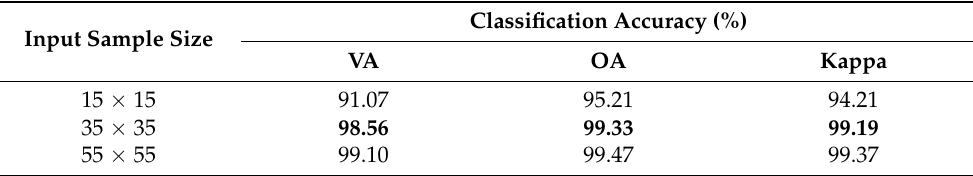
Table 7. The classification performance of MSCDN with different sample size.